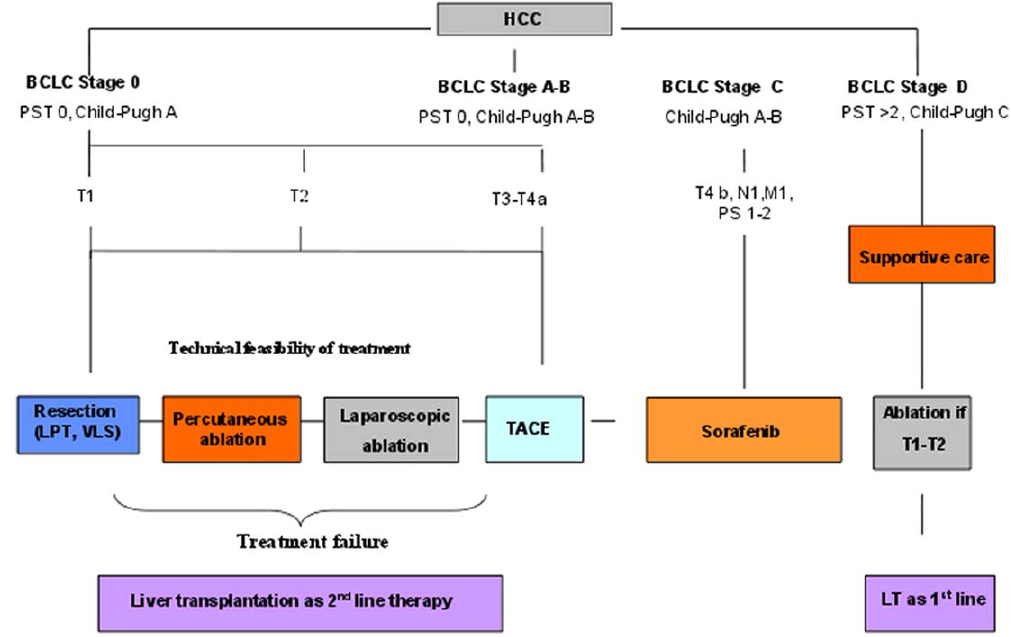
Figure 1. The Padua treatment algorithm for HCC patients.